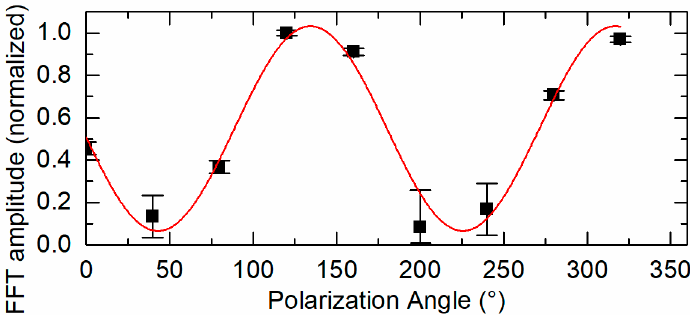
Figure 3. Peak amplitude value of the response of the LiNbO 3 layer plotted as a function of the polarization angle of the incident pulse. The red solid line shows a fit through the experimental data points (black squares) which exhibits a sinusoidal behaviour with π periodicity. The error is estimated by the mean average of the noise floor together with the standard deviation.